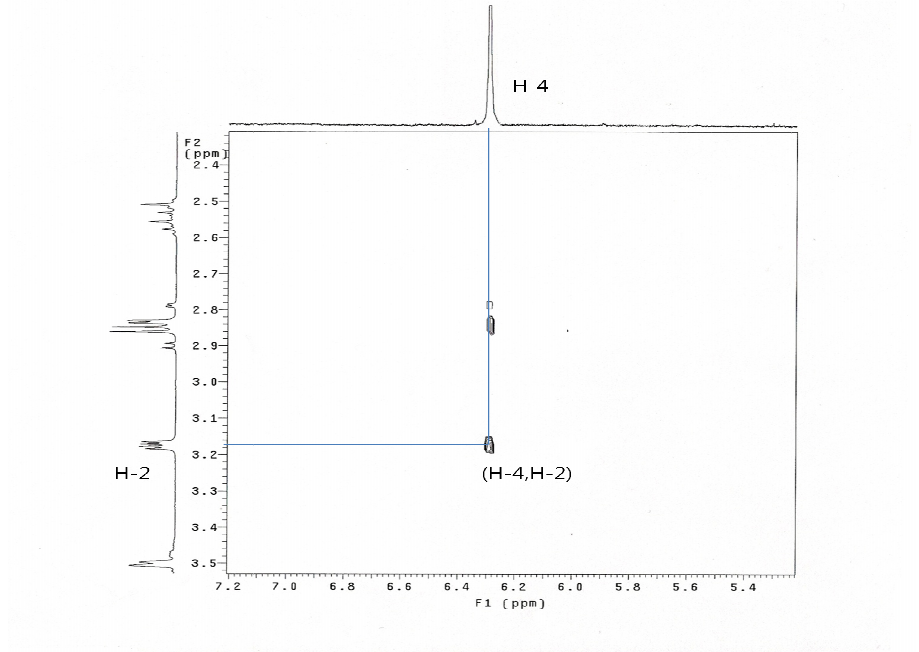
Figure 2. 1 H- 1 H COSY spectrum of compound 14